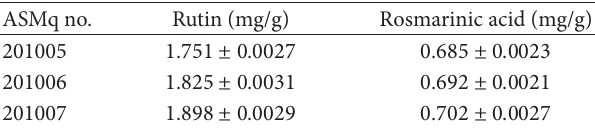
T2:Quanti�cationofrutinandrosmarinicacidinthreebatches of